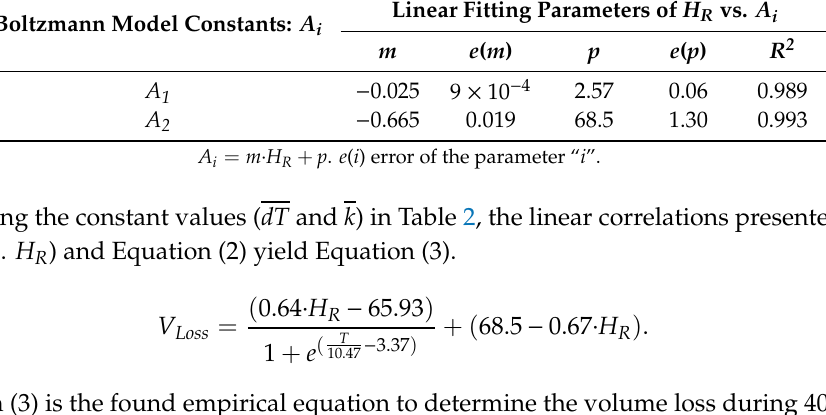
Table 3. Linear fitting parameters between the Boltzmann A 1 and A 2 constants and H R . Linear Fitting Parameters of H R vs. A i Boltzmann Model Constants: A i